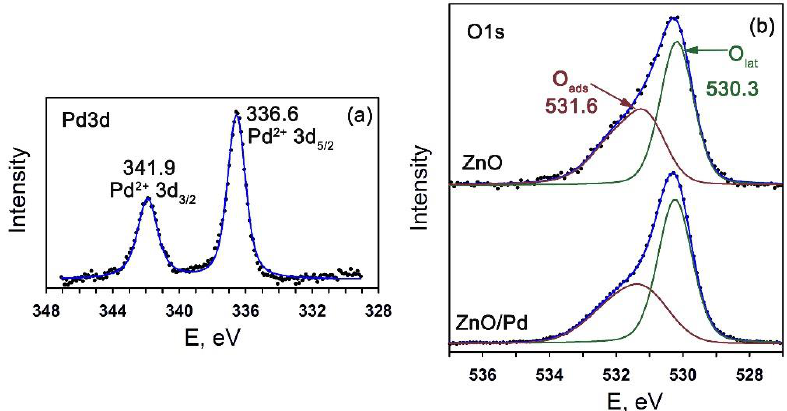
Figure 4. ( a ) Pd3d XP-spectrum of ZnO/Pd nanofibers. ( b ) O1s XP-spectra of the ZnO and ZnO/Pd nanofibers.